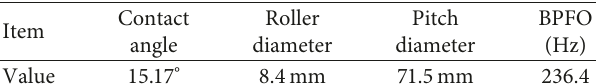
Table 1: Parameters of ZA-2115 and its fault frequency of outer race.